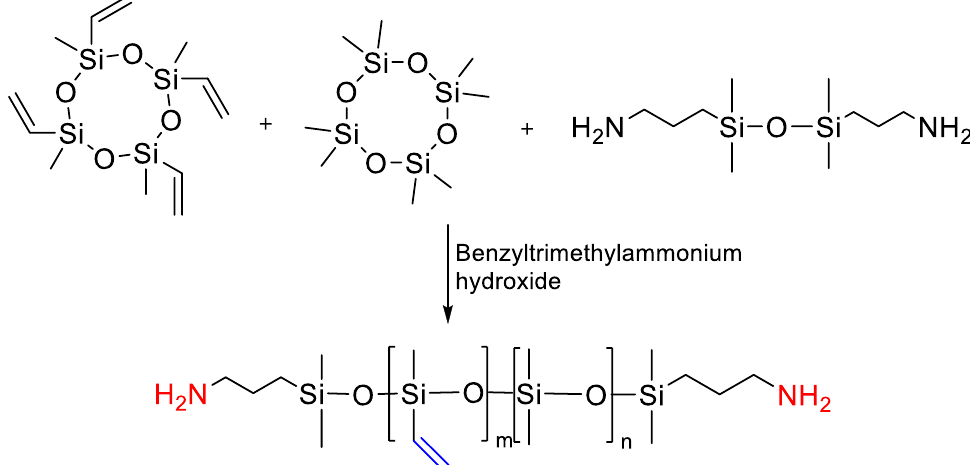
Figure 36. Synthesis of siloxane polymers having terminal amine functionality.